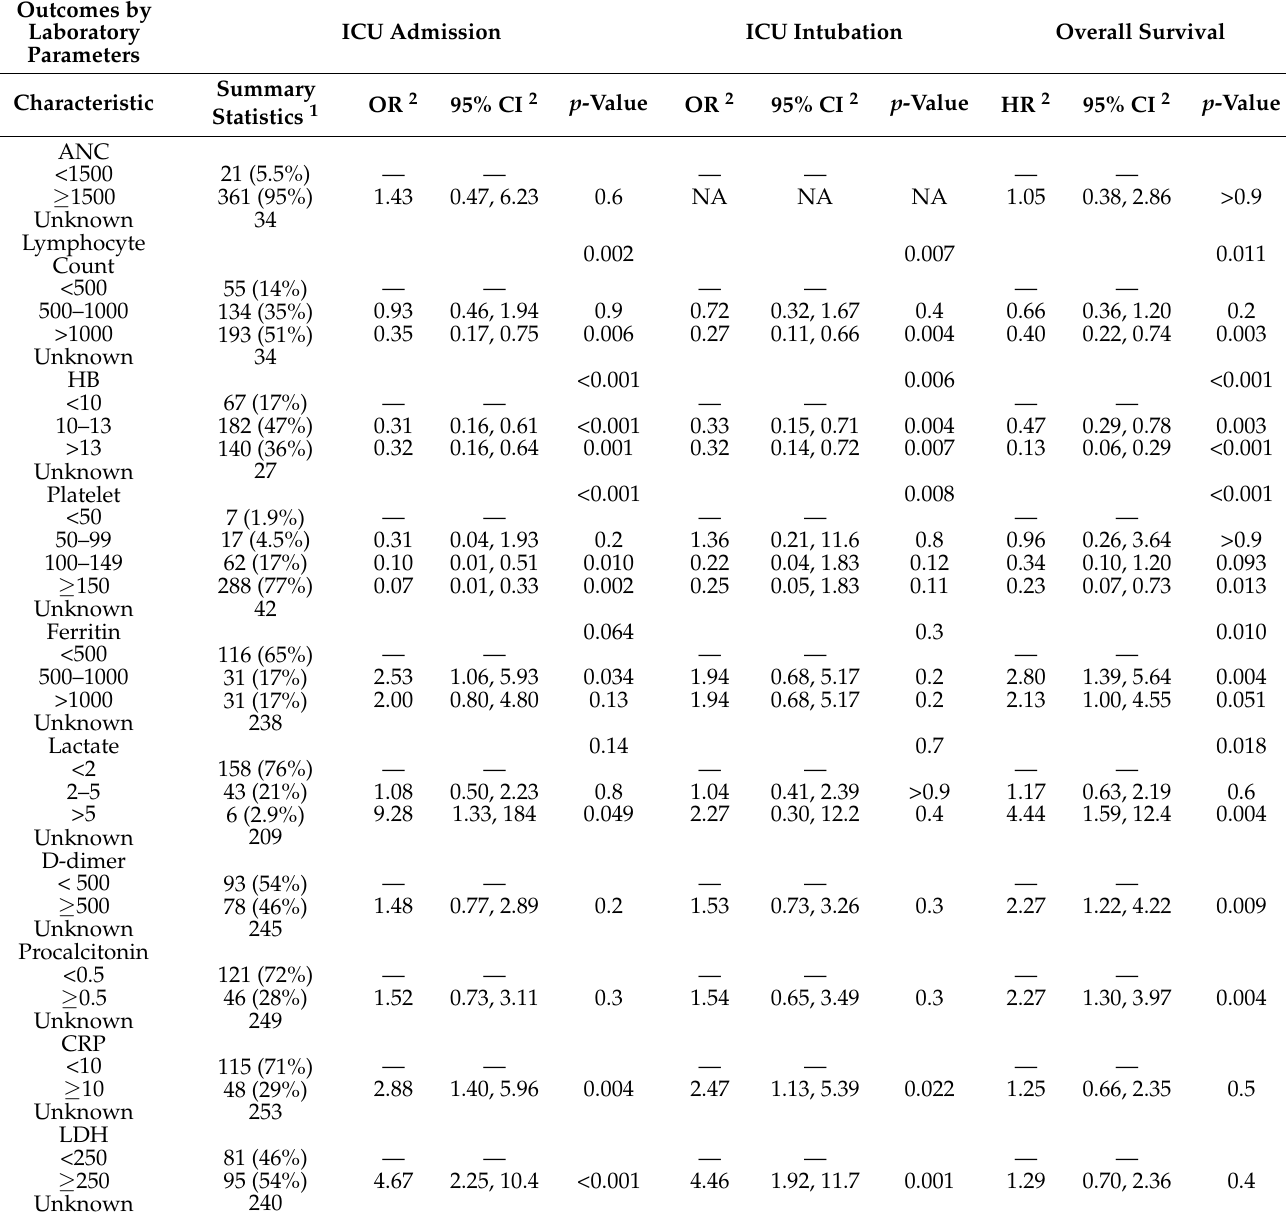
Table 4. ICU admission, ICU intubation, and overall survival according to laboratory